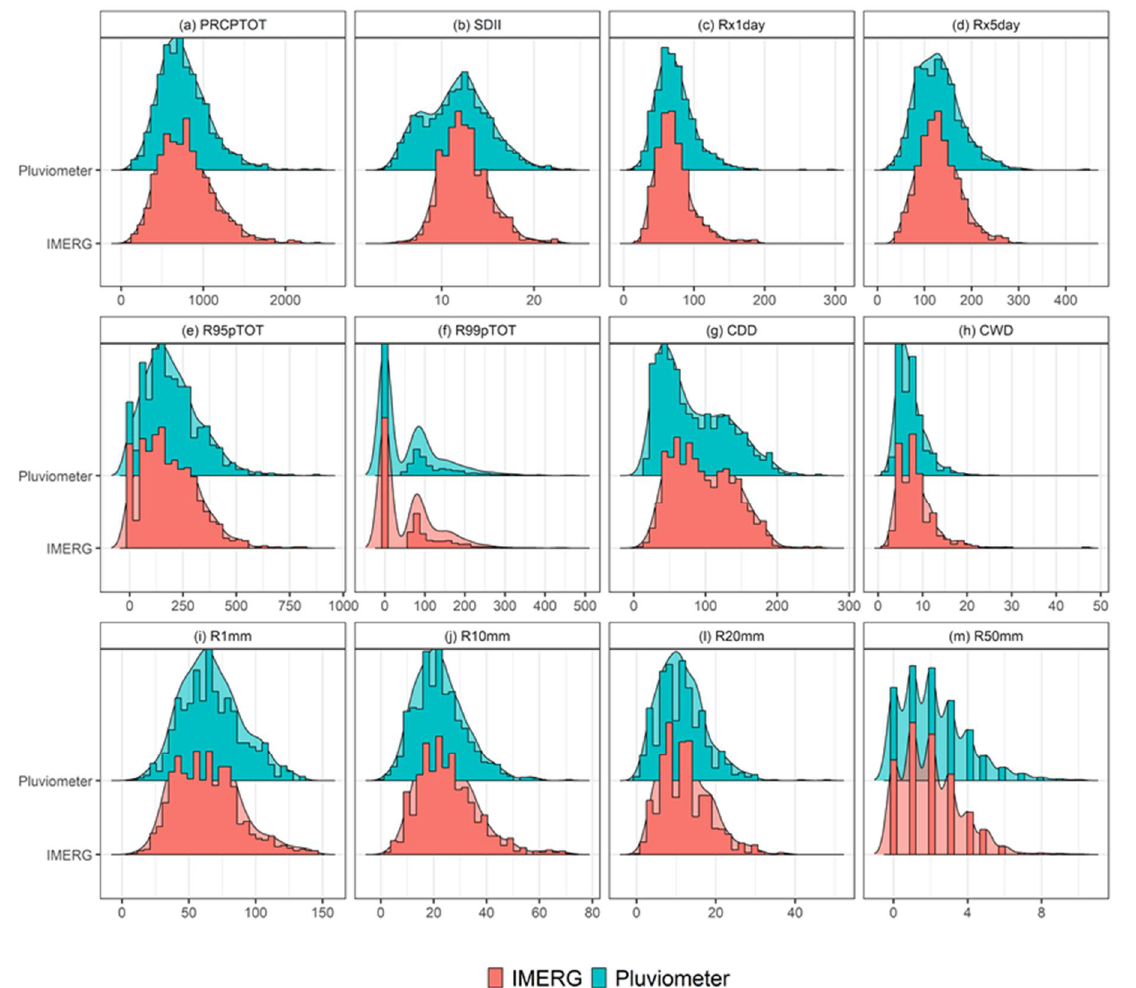
Figure 7. PDF of the climatic indices for the 56 points of comparison between IMERG and rain gauges. The histograms represent the empirical distribution. The curves represent the density estimated using the kernel method, ( a ) PRCPTPT, ( b ) SDII, ( c ) Rx1day. ( d ) Rx5day, ( e ) R95pTOT, ( f ) R99pTOT, ( g ) CDD, ( h ) CWD, ( i ) R1mm, ( j ) R10mm, ( l ) R20mm, ( m ) R50mm.